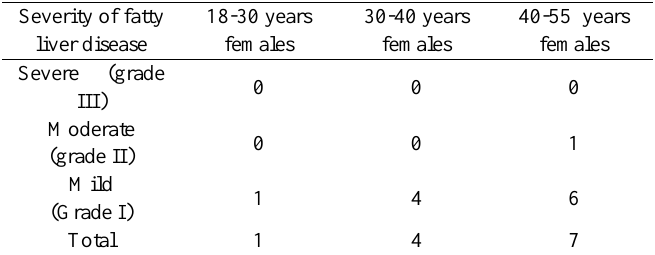
Table 5: Incidence of NAFLD in relation to age in overweight males Severity of fatty liver